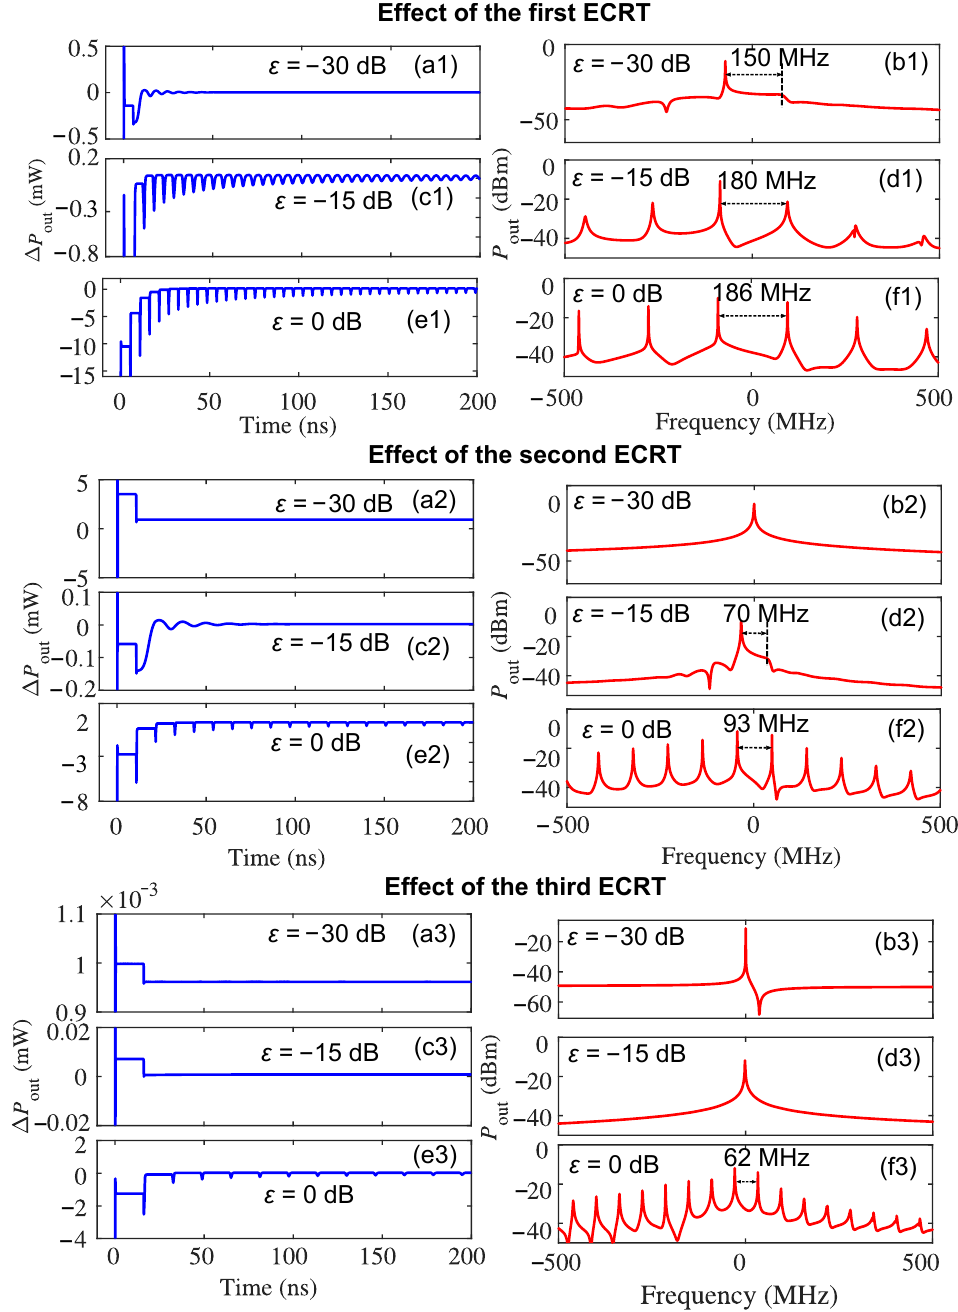
Figure 2. The effects of the first, second, and third ECRT on the self-pulsation dynamics in a THz QCL under varying optical feedback levels, respectively: ( a , c , e ) are the AC component of the emission power ∆ P out when ε is − 30 dB, − 15 dB, and 0 dB, respectively; ( b , d , f ) are the emission spectrum (offset to the emission frequency 2.752 THz) when ε is − 30 dB, − 15 dB, and 0 dB,